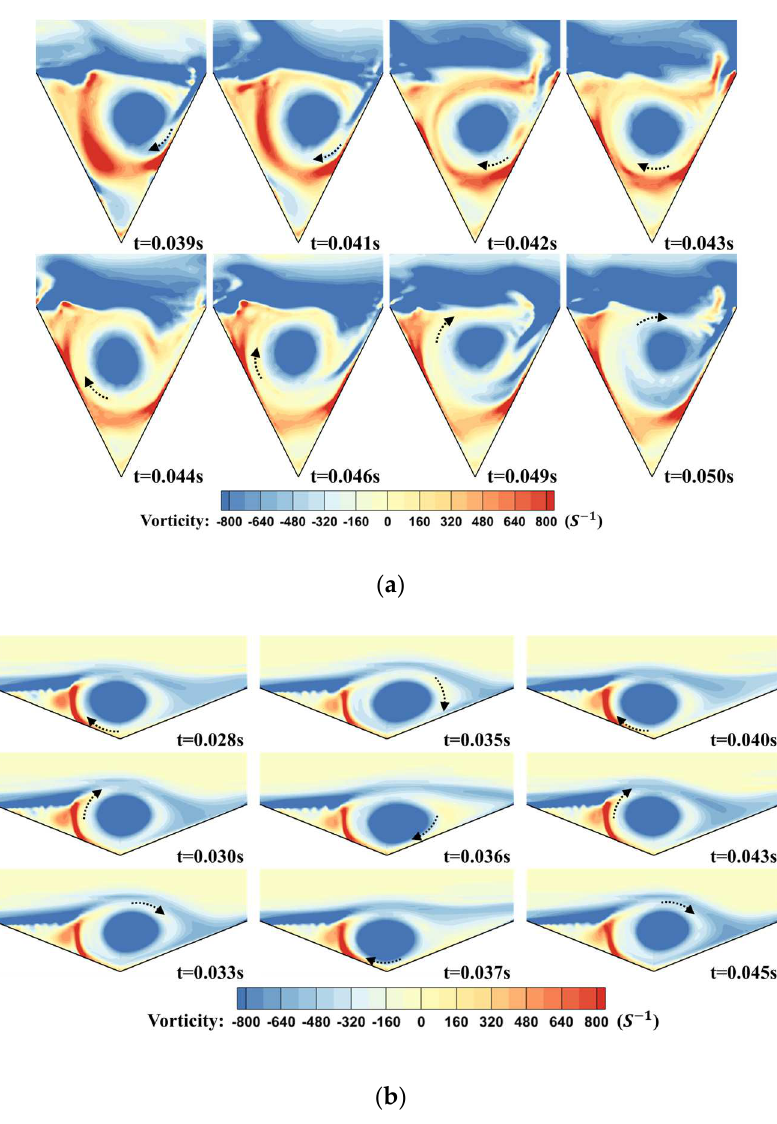
Figure 19. The vorticity contours of boundary vortices within grooves with ( a ) AR = 1, ( b ) AR = 5 at Re = 5.44 × 10 4 .